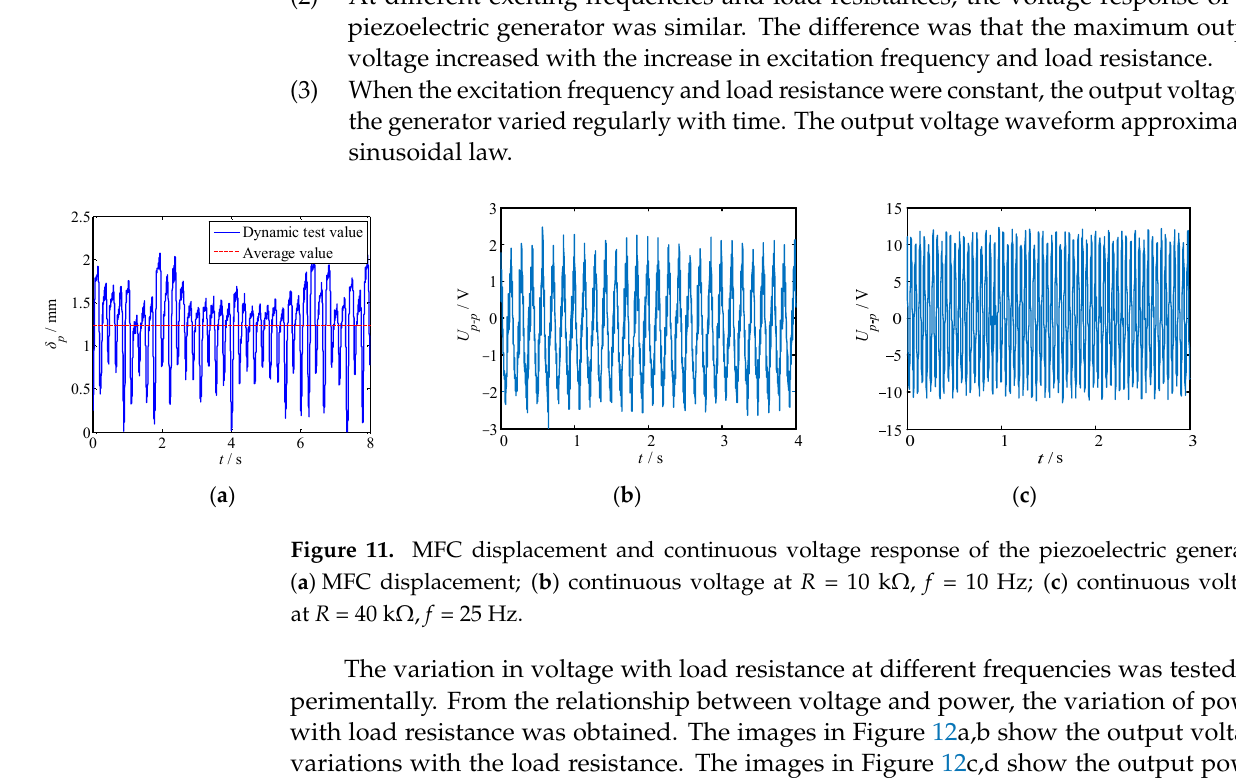
plitude of the piezoelectric MFC was measured, and the test result is shown in Figure